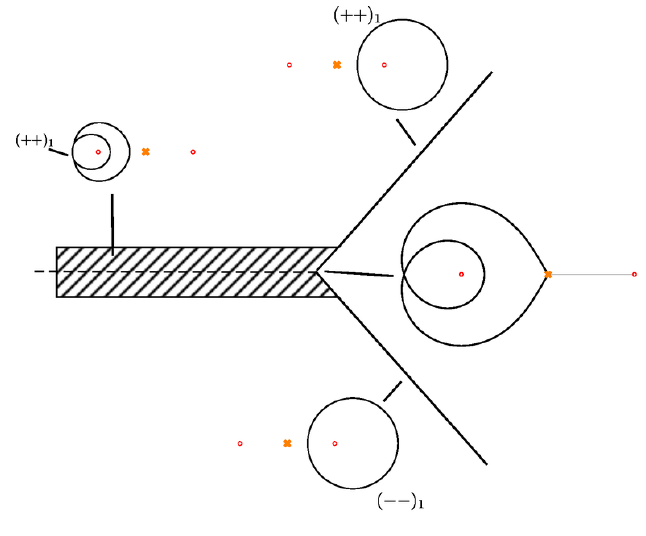
Figure 52. Moduli of D0-brane on C 3